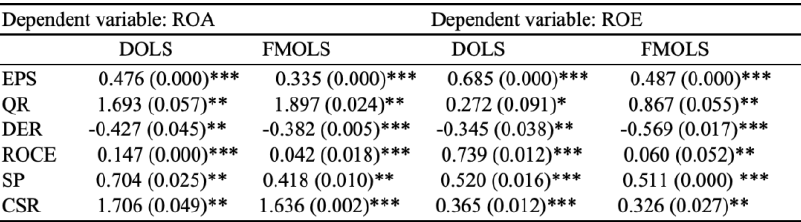
Table 4: Panel DOLS and FMOLS estimation